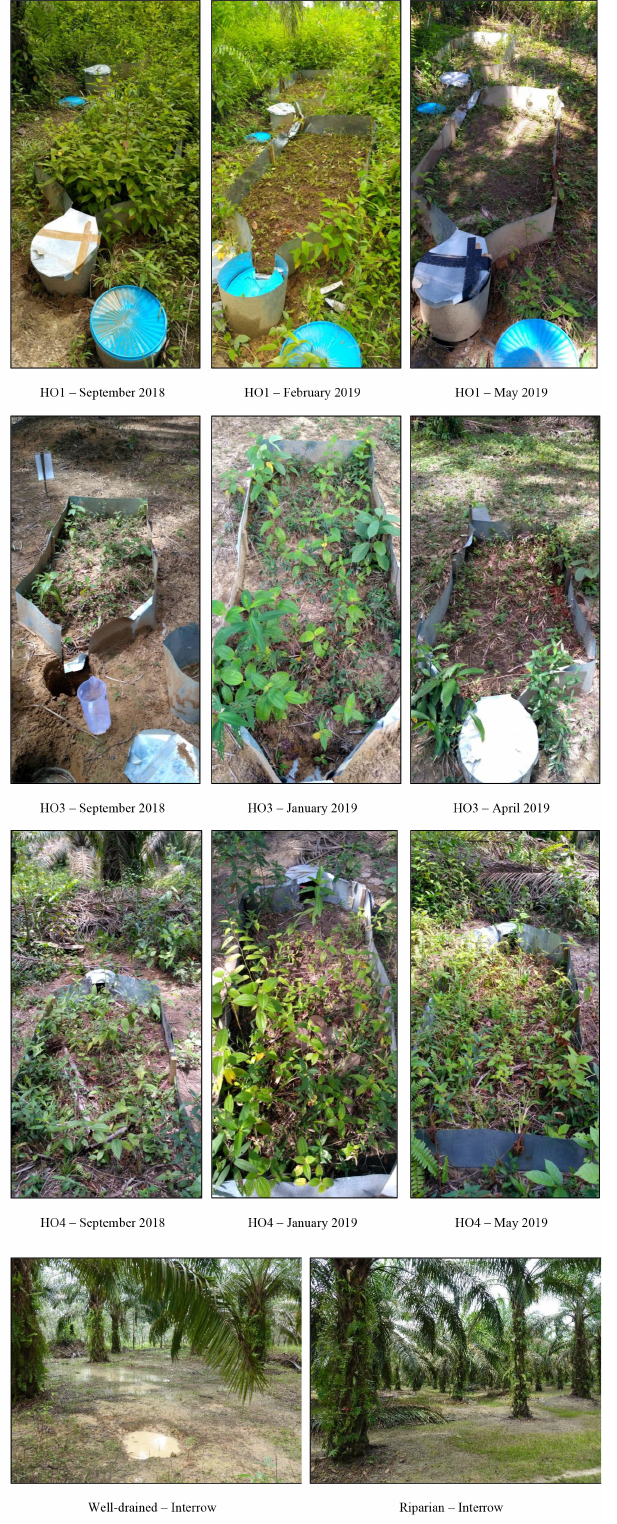
Table A3. Sediment traps in interrows of well-drained oil-palm